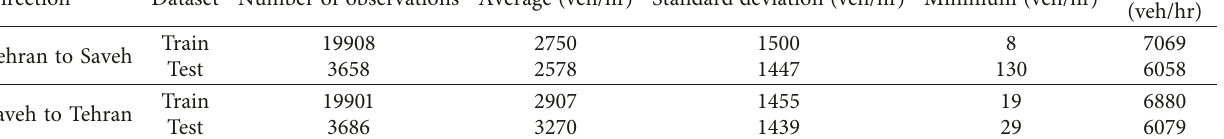
Figure 2: Traffic flow histograms for train and test datasets of Saveh–Tehran road. (a) Histogram of train dataset for Tehran to Saveh. (b) Histogram of test dataset for Tehran to Saveh. (c) Histogram of train dataset for Saveh to Tehran. (d) Histogram of test dataset for Saveh to Tehran. Table 2: Statistical summary description of traffic flow.